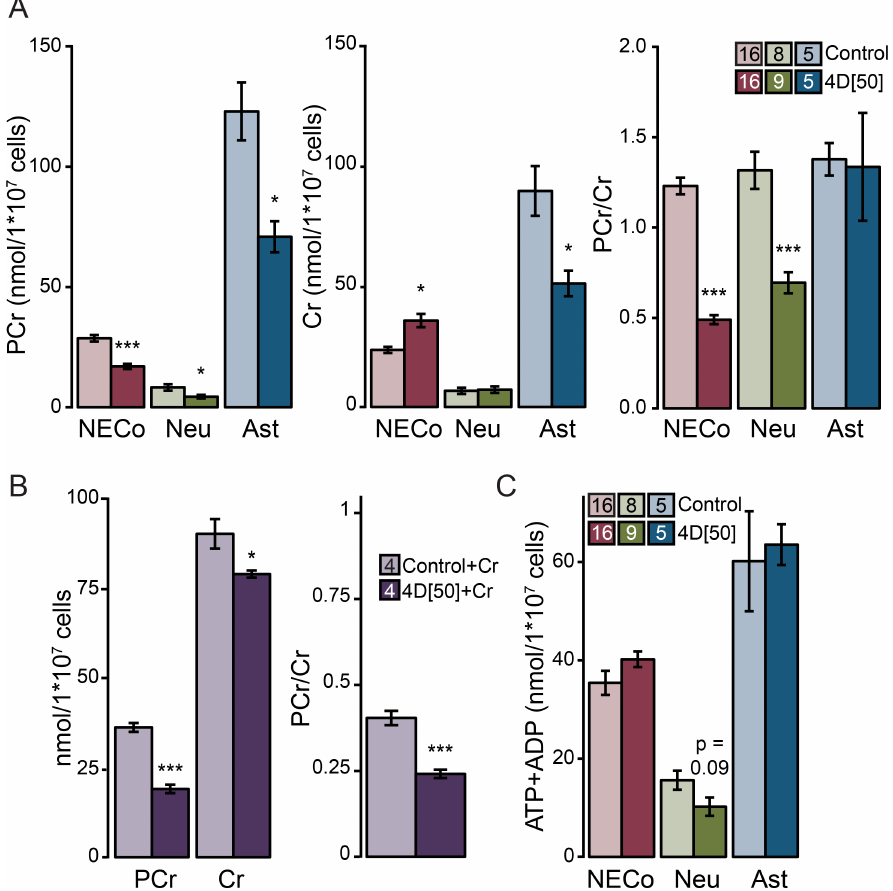
Fig 7. Reduced mitochondrial function decreasesneuronal PCr/Cr ratio, and decreasesglial tCr. (A) Phosphocreatine(PCr), creatine(Cr), and PCr/Cr ratio in NECos, neurons, and astrocytes, with and without EtBr. (B) Absolute PCr, Cr, and PCr/Cr ratio in neuronalcultures supplemented with 5 mM Cr 24h before harvest, with and without EtBr. (C) ATP+ADP in NECos, neurons, and astrocytes, with and without EtBr. N for each group is includedin figure legends. Error bars reflect +/-SEM. *** = p < 0.001; ** = p < 0.01; * = p < 0.05, comparedto respectivecontrols.